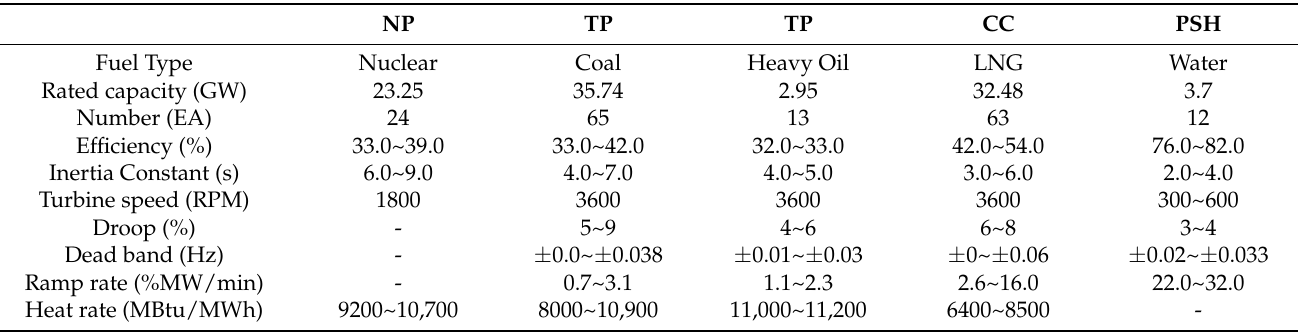
Table 1. Typical parameter of CPP models